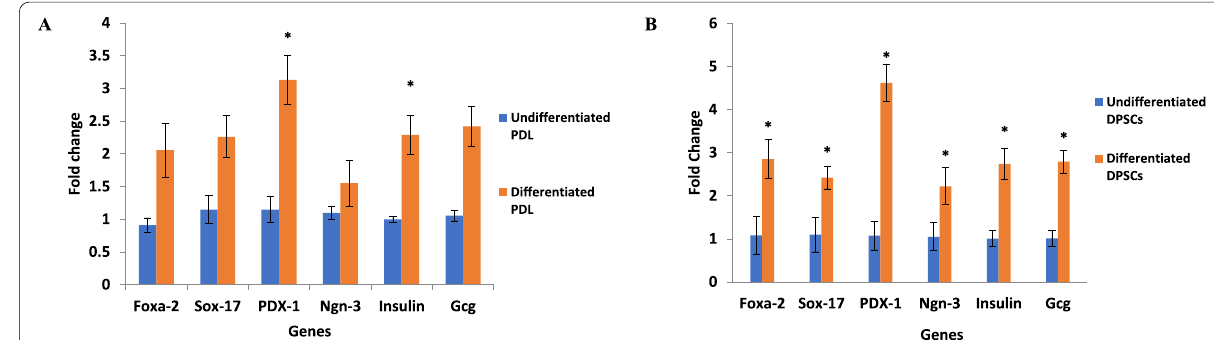
Fig. 5 Expression of pancreatic endocrine genes in generated IPCs from hDPSCs ( A ) and hPDLSCs ( B ). Data are expressed as means * Significant change at P < 0.05 in comparison with the corresponding undifferentiated cells